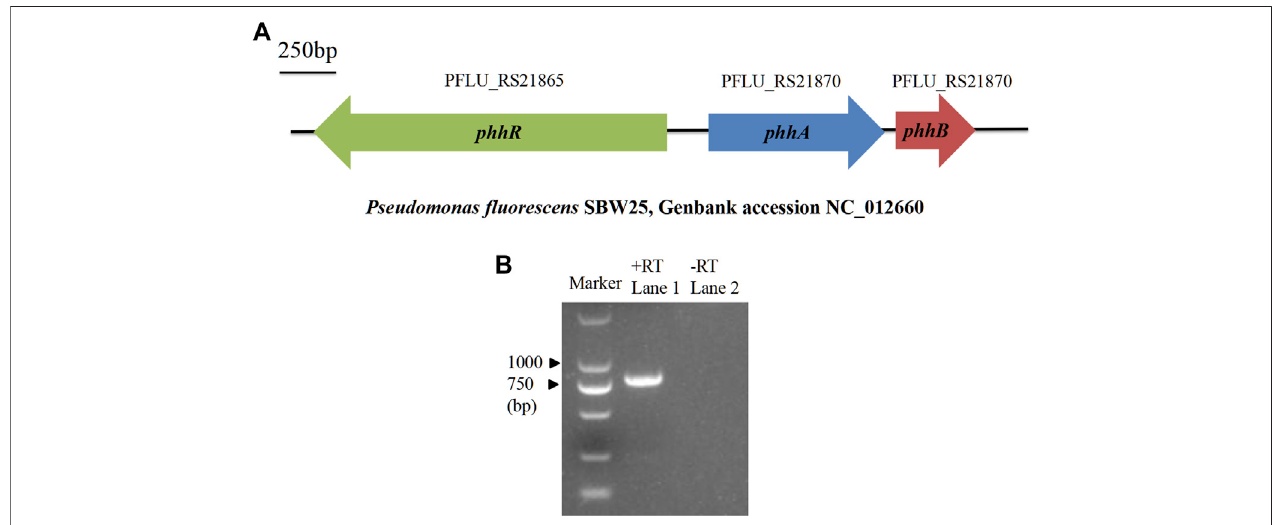
FIGURE1| Locationandexpressionof phhA . (A) Descriptionofthelocationof phhA anditsneighboringgenesinthe P. fl uorescens genome.Thehorizontalarrows indicate the genes ’ orientation and relative size. phhR and phhB are responsible for encoding sigma-54-dependent phenylalanine hydroxylase transcriptional regulator and pterin-4 α -carbinolaminedehydratase,respectively. (B) Reversetranscription(RT)-PCRanalysisofthe phhA expression intheRG11strainafterculturinginBPliquid medium.Lane1,RT-PCRwithprimersdesignedforfull-length phhA (792 bp) , andthecDNAwasusedasthetemplate;lane2,thesameprocessasintheassayin lane 1, but used mRNA as a template without reverse